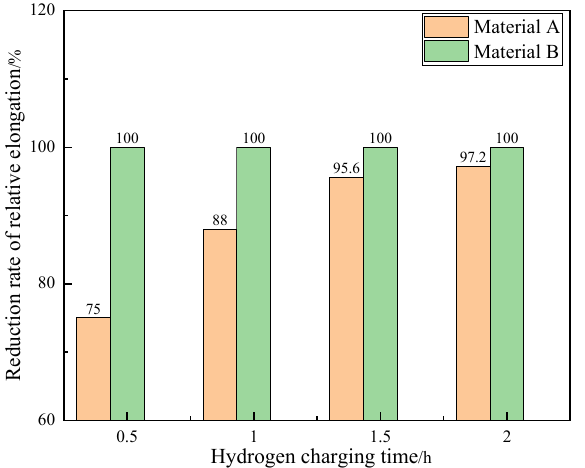
Figure 4. Relative elongation reduction rate at different hydrogen charging times.